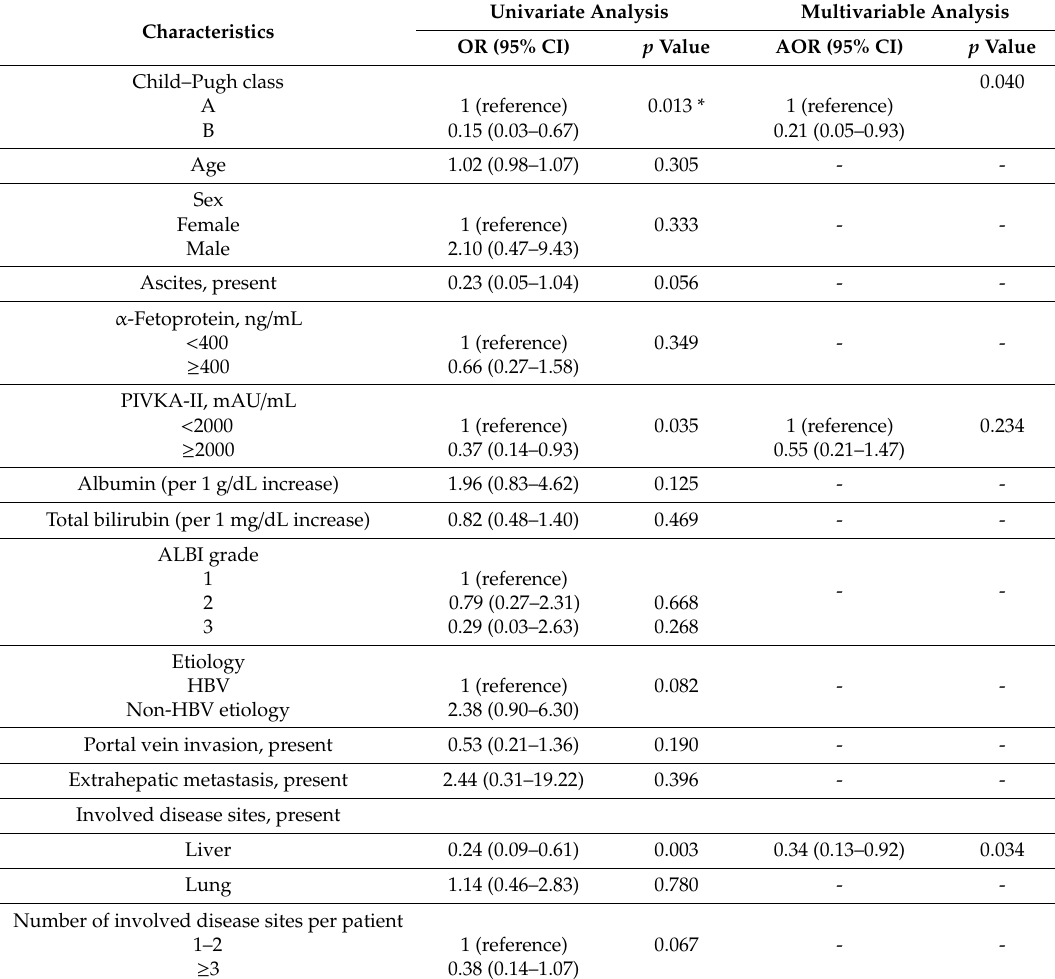
Table 6. Predictive factors for treatment